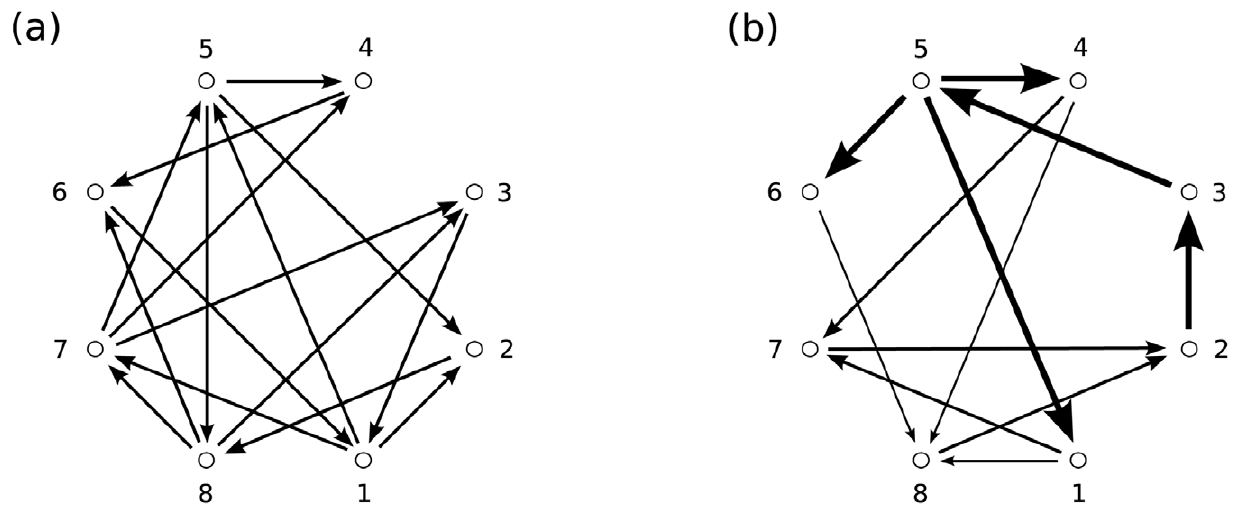
Figure 2. Networks optimized for high integrated information. (a) Optimal network for 2 afferents of 0.25 to each node. This has W E ~ 0 : 2502 . (b) Optimal network for total afferent of 0.5 to each node, and all connections to a given node equal. This has W E ~ 0 : 2965 .